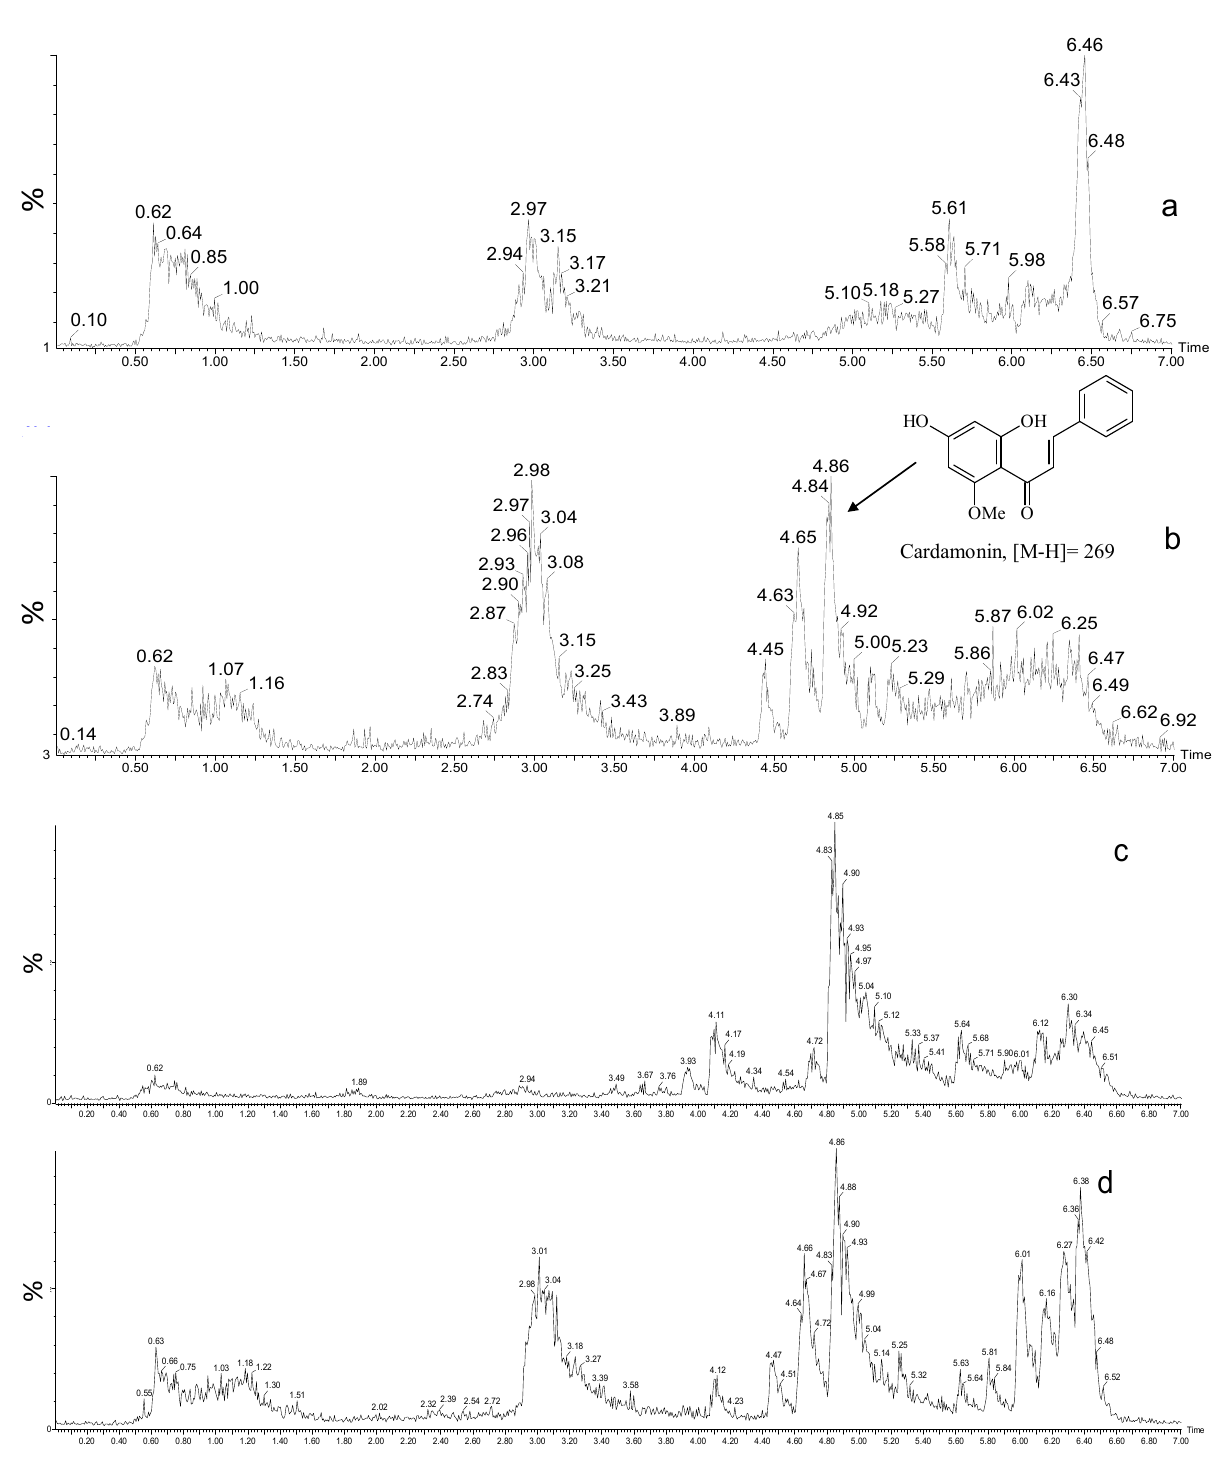
Figure 1. Chemical structure of cardamonin and chromatographic profile of extracts from leaves and fruits of Campomanesia adamantium by UPLC/MS/MS in negative ion mode. ( a ) fruit extract; ( b ) leaf extract; ( c ); fruit extract + standard sample of cardamonin ( d ) leaf extract+ standard sample of